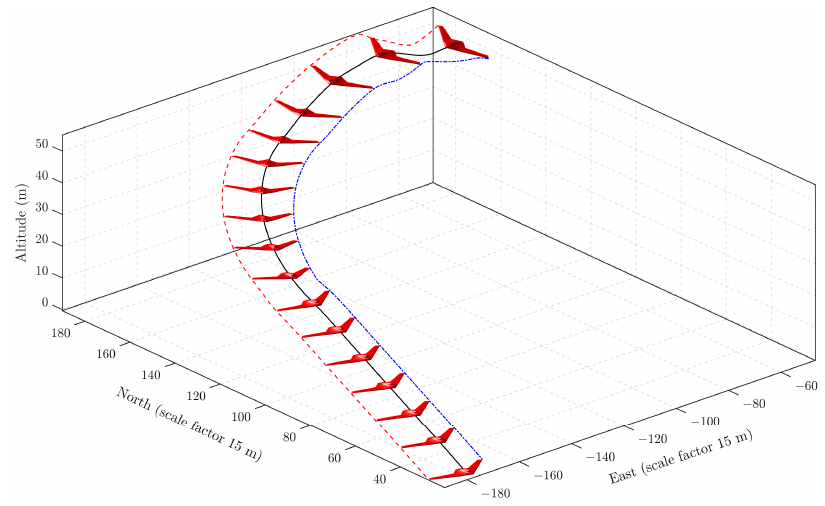
Figure 21. Three-dimensional trajectory of short landing.